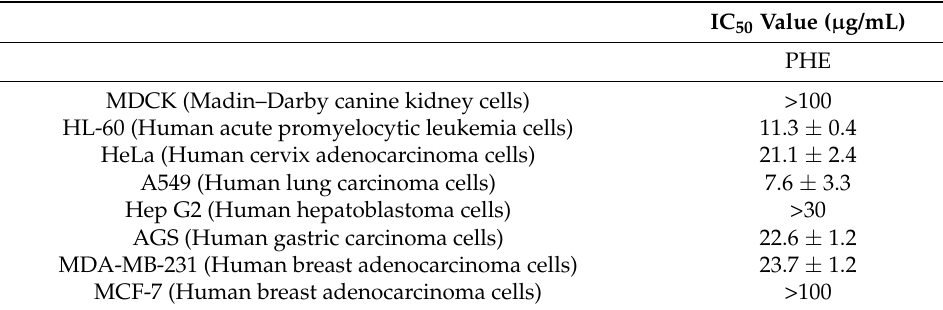
Figure 1. Effect of Physconia hokkaidensis methanol extract (PHE) on the viability of various cell lines. Seven cancer cell lines and a normal cell line were treated with the PHE (1, 3, 10, and 30 µg/mL) for 24 h. The culture supernatant was removed and cell counting kit-8 was added. Viability was quantified using a microplate reader. All data are expressed as mean ± SD of three independent experiments. * p < 0.05, ** p < 0.01, *** p < 0.001 compared to the control of each cell line. Table 1. Effect of PHE on the viability of various cell